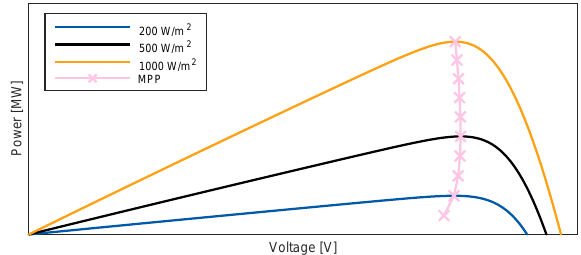
Figure 1. PV panel power characteristics as a function of the DC voltage and solar